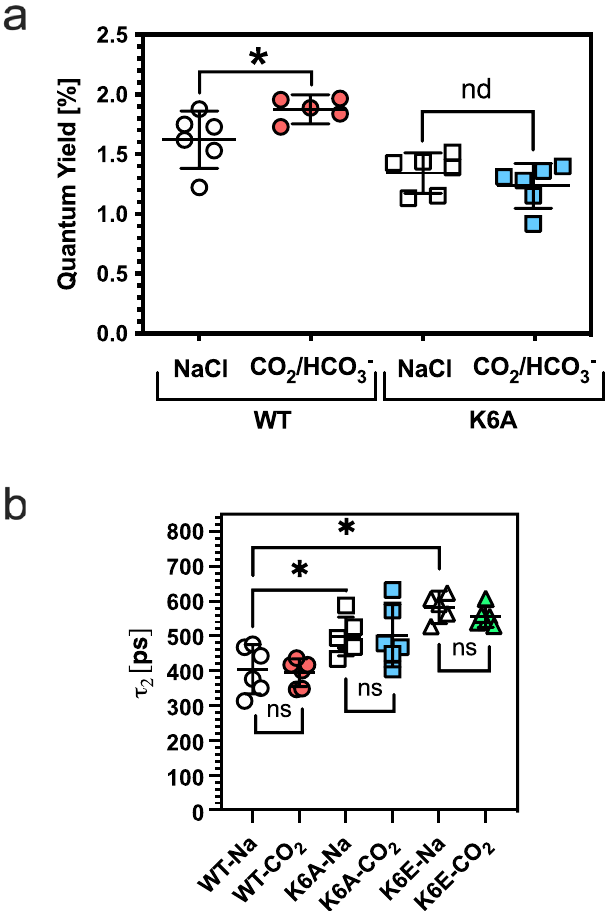
Fig. 5 | CO 2 enhances ApcAB QY in vivo. a The measured fl uorescence QY with 1mM NaHCO 3 (CO 2 /HCO 3 − ) or NaCl for Synechocystis sp. PCC 6803 wild type or K6A cells (* q =0.0058, one-way ANOVA with post hoc two-stage linear set-up procedure of Benjamini, Krieger and Yekutieli, n =6 independent replicates for WT+NaCl, K6A+NaCl and K6A+CO 2 , n =5 independent replicates for WT+CO 2 , t =2.382, df =19,ndnodiscovery,mean±95% CI ). b Thesecond fl uorescentlifetime component (Table 1) with 1mM NaHCO 3 (-CO 2 ) or NaCl (-Na) for Synechocystis sp. PCC 6803 wild type, K6A, or K6E cells (* p <0.05, ns=not signi fi cant, two-way